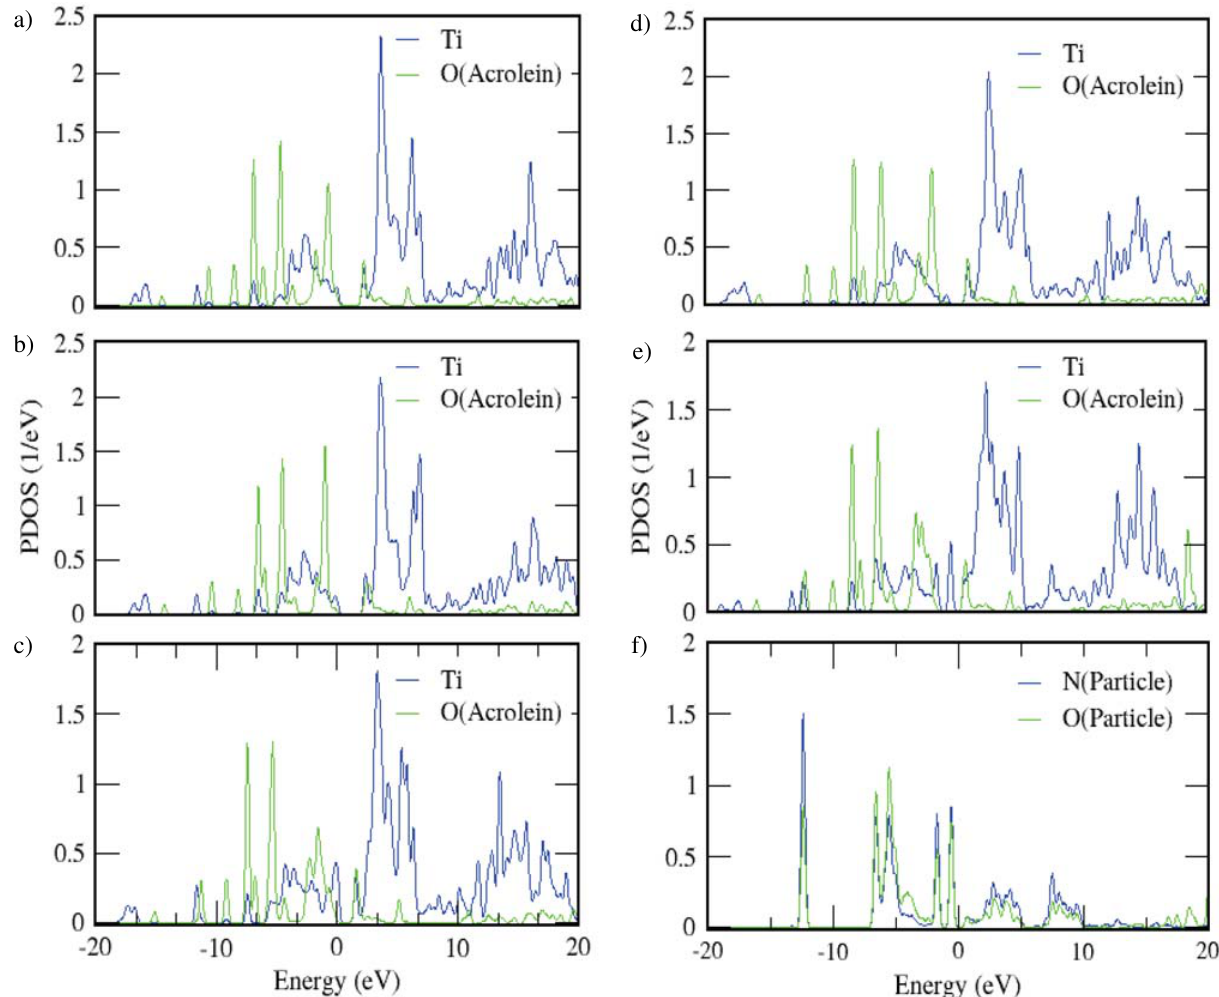
Figure 4. PDOS for the adsorption of C A4; e: Complex A5; f: Complex A5